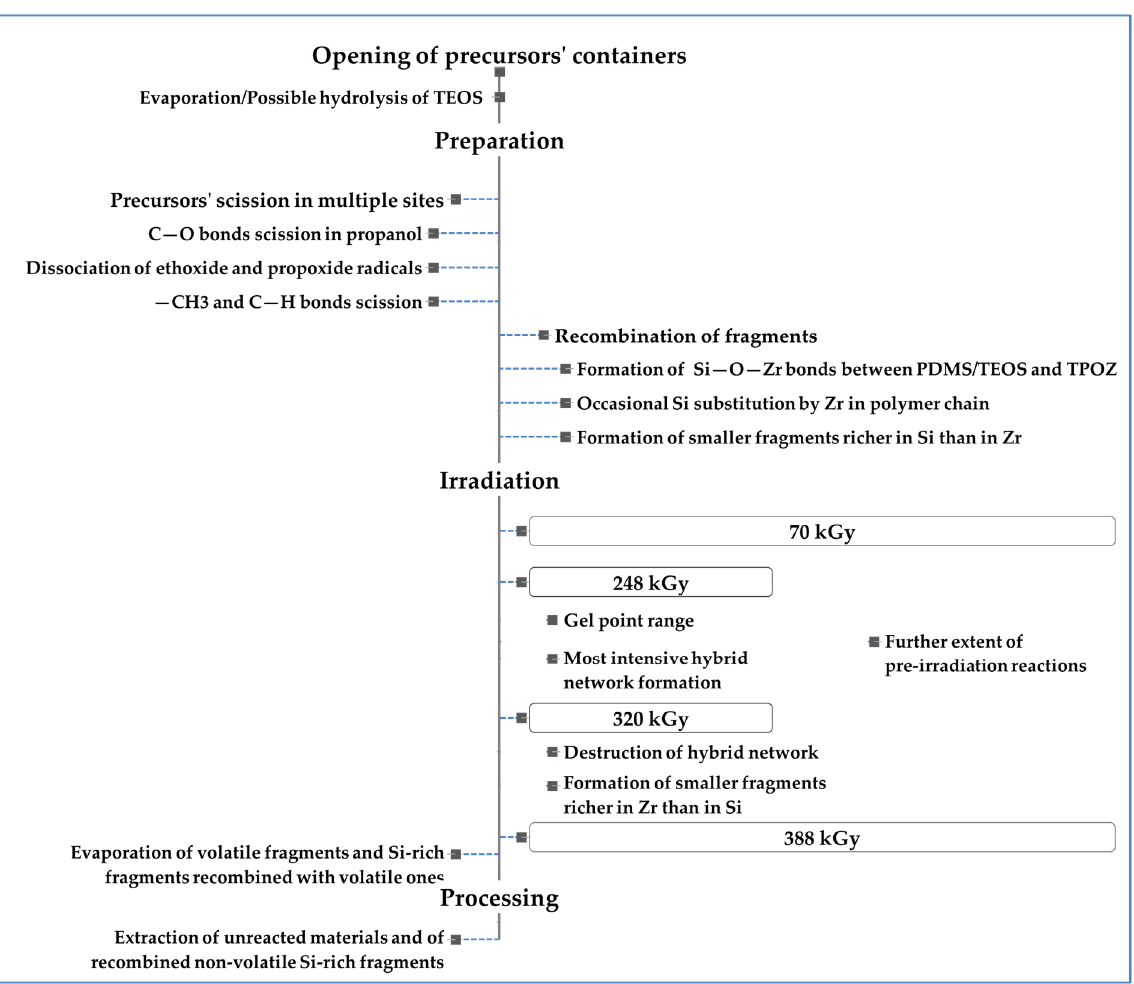
Figure 8. Proposed sequence of events in the production of e-HM in PDMS:TEOS:TPOZ/67:13:20 system.